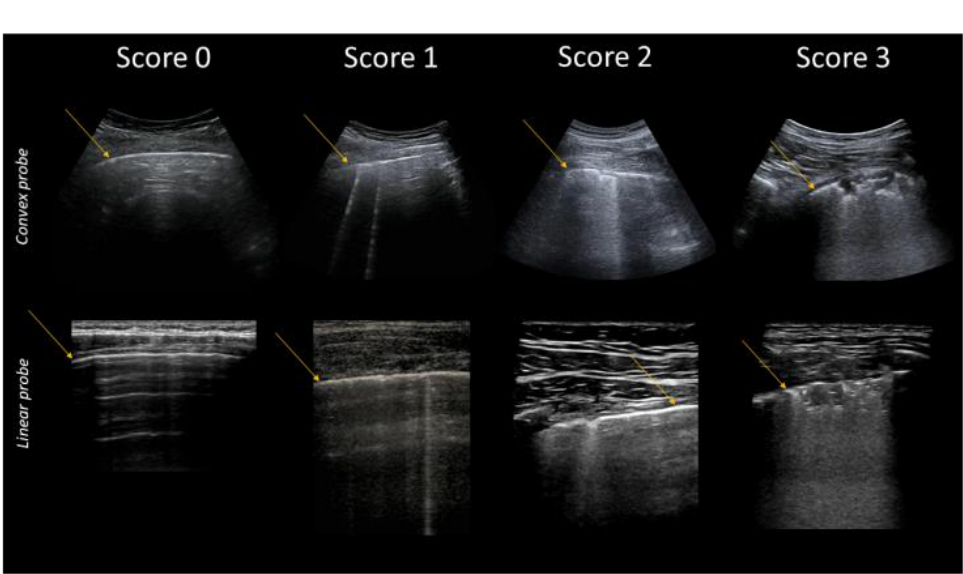
Figure 4. Classification of pathological lung ultrasound findings in COVID-19 patients. Arrows indicate the pleural line. Top: convex probe. Bottom: linear probe.